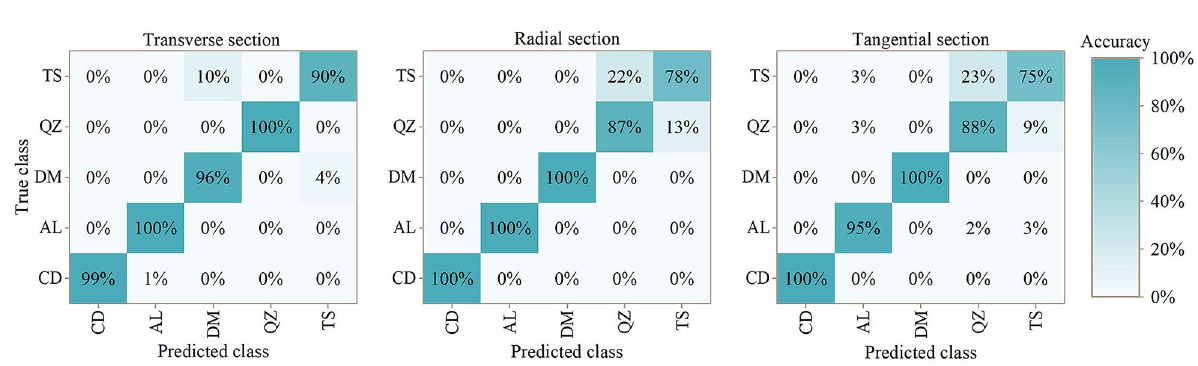
Figure 6. Mixing matrix for results of five Guiboutia species with PLS-DA model (based on SPA spectral treatment). CD = G. conjugate ; AL = G. ehie ; DM = G. demeusei ; QZ = G. coleosperma ; TS = G. tessmannii